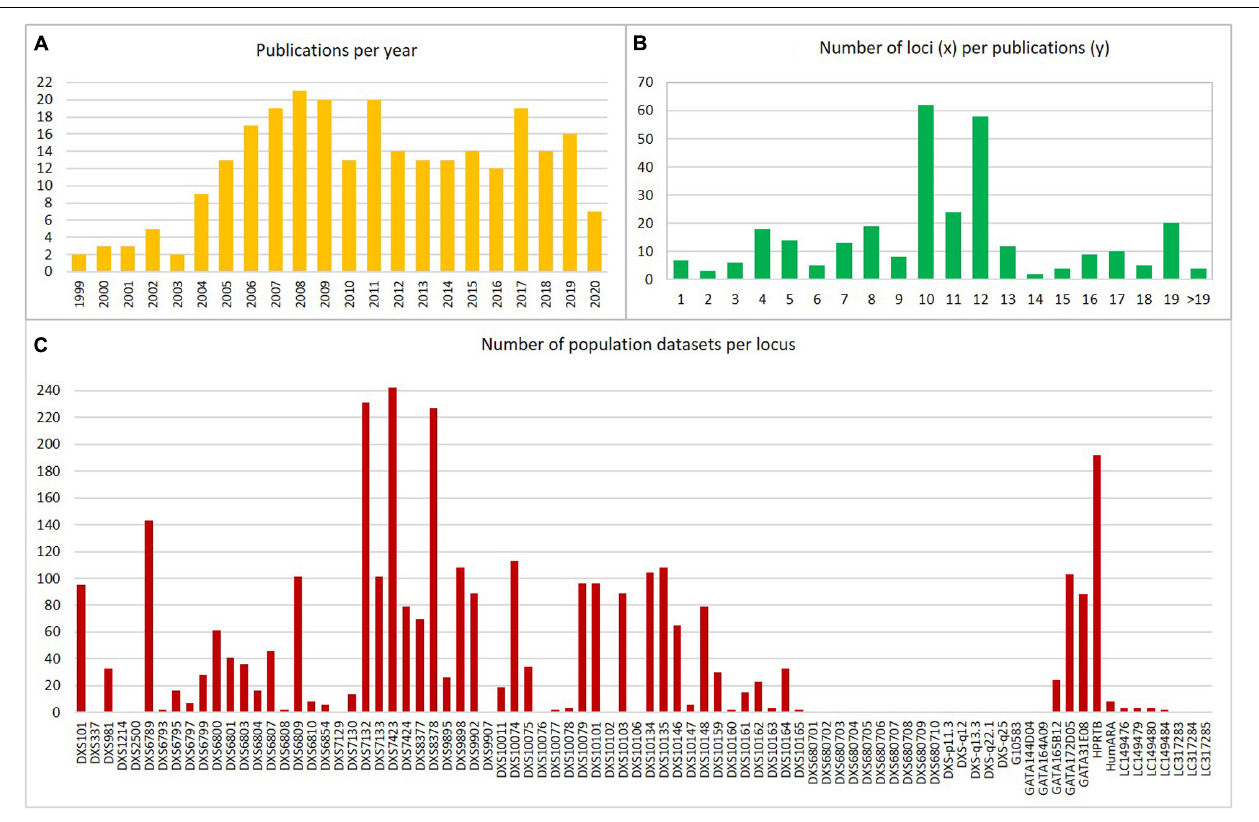
FIGURE 2 | Representation of the compiled human population datasets: (A) Number of publications per year; (B) Number of loci per population datasets; (C) Number of population datasets per locus. Data were obtained from publications referenced in Supplementary Table 2